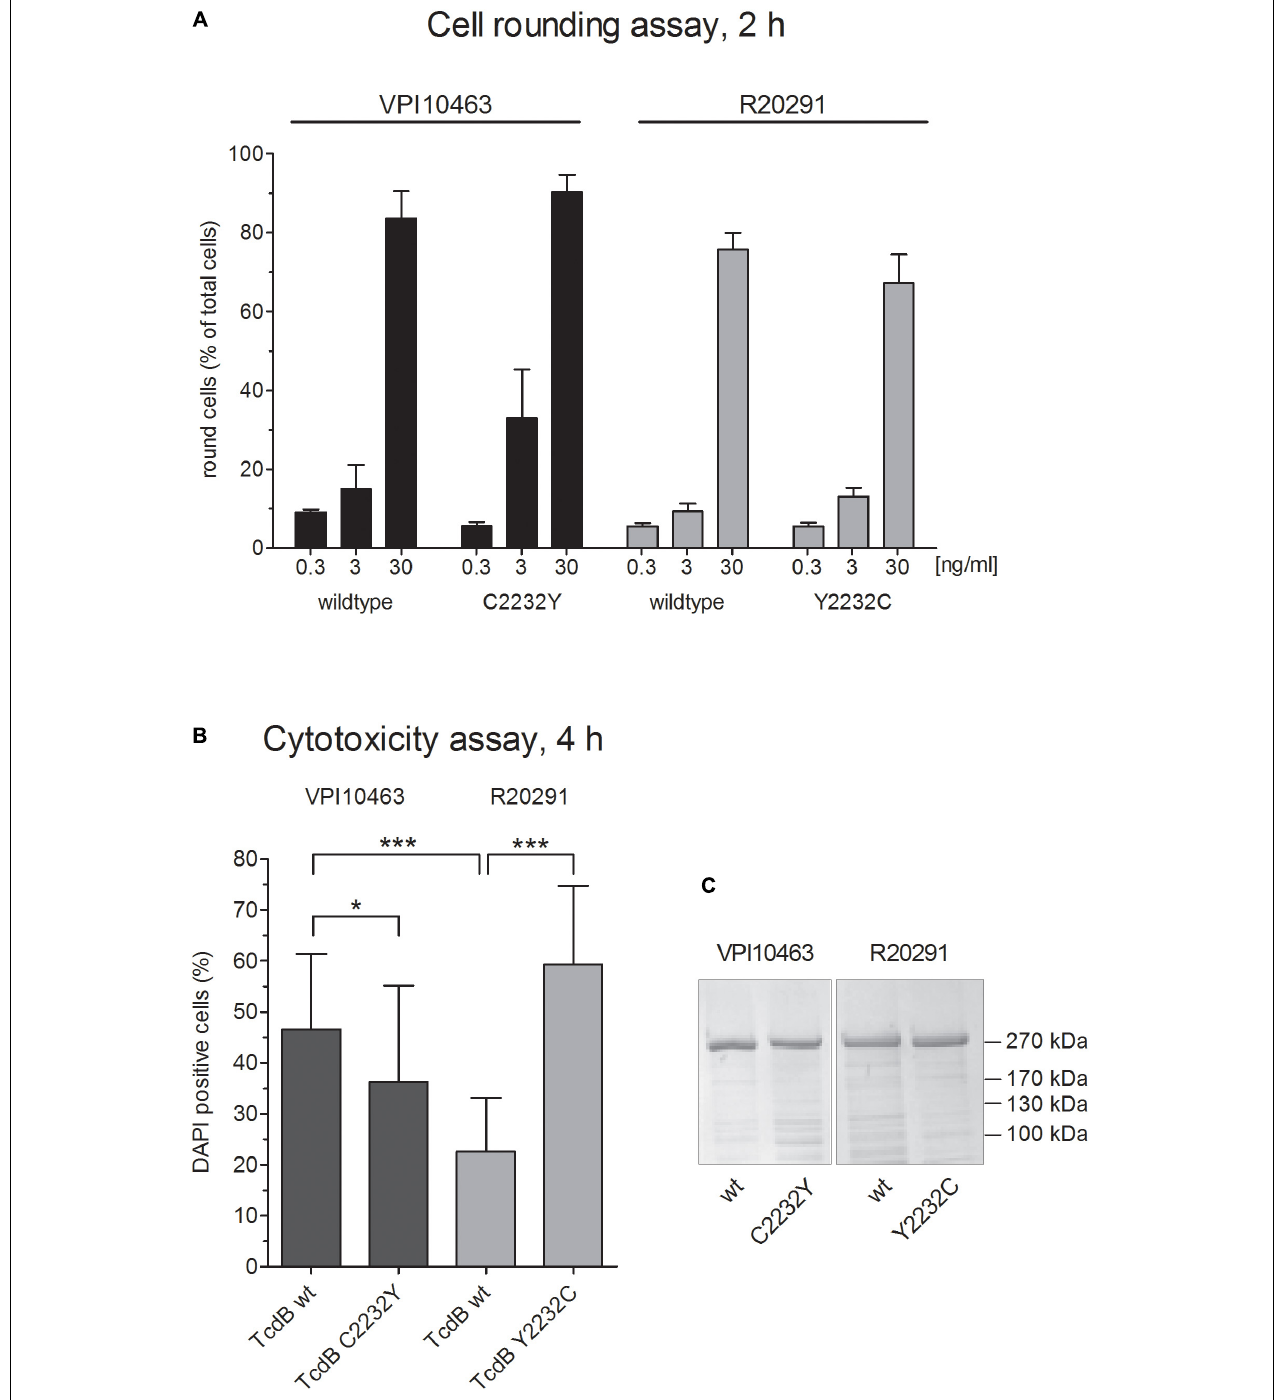
FIGURE 1 | Cytopathic and cytotoxic effect of clade I and II TcdB. (A) Dose-dependent cytopathic effect of TcdB and TcdB C2232Y from strain VPI10463 (clade I) as well as TcdB and TcdB Y2232C from strain R20291 (Clade II). Shown are the percentage of rounded cells after treatment with TcdB at given concentrations for 2 h (means ± SD, n = 6). (B) Cytotoxic effect of indicated toxins after treatment of cells with 1 µ g/ml for 4 h (means ± SD, n = 24). (C) Coomassie stained SDS-gel of all four toxins used in panels (A,B) showing comparable purity and concentration.